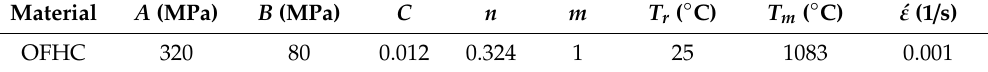
Table 4. Johnson-Cook parameters for coarse-grained OFHC copper [27].